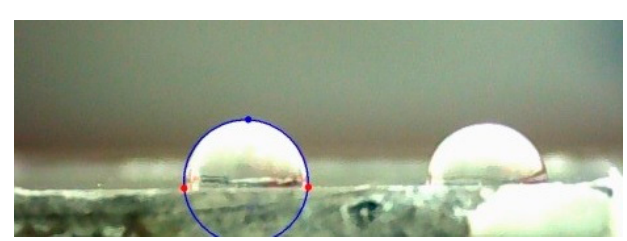
Figure 16. Sample photo of a drop on the surface of the G sample layer.